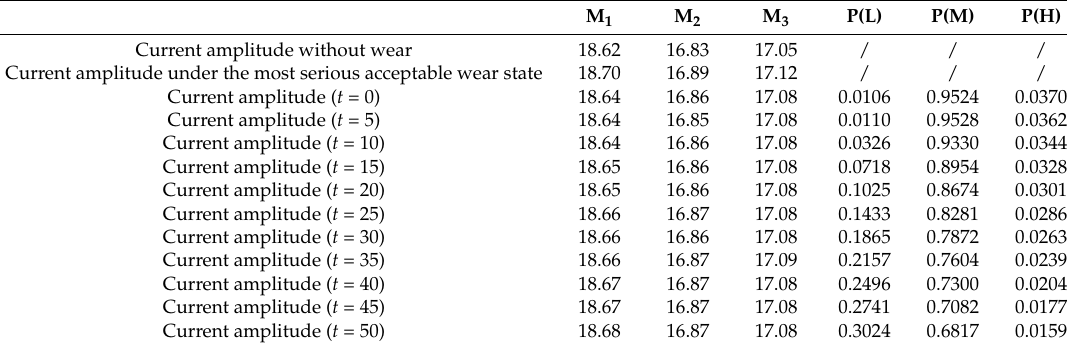
Table 4. Performance state of the manufacturing